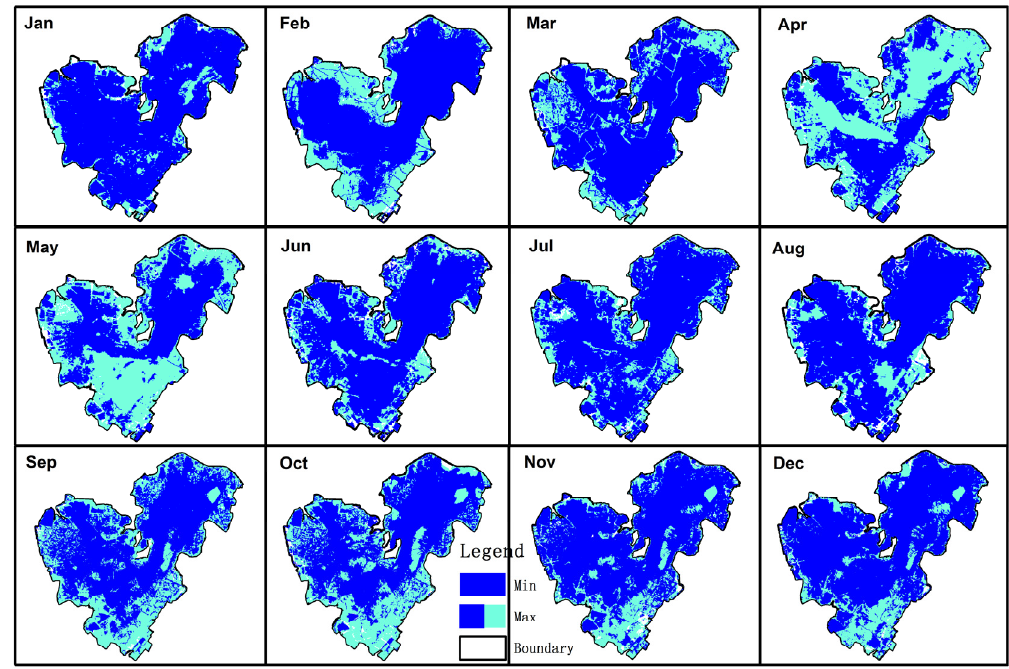
Figure 2. Monthly minimum and maximum area distributions of the Honghu Lake from the 1990s to